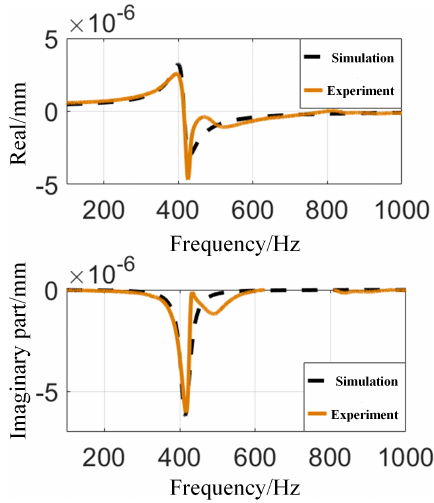
Figure 4. Frequency response function of the